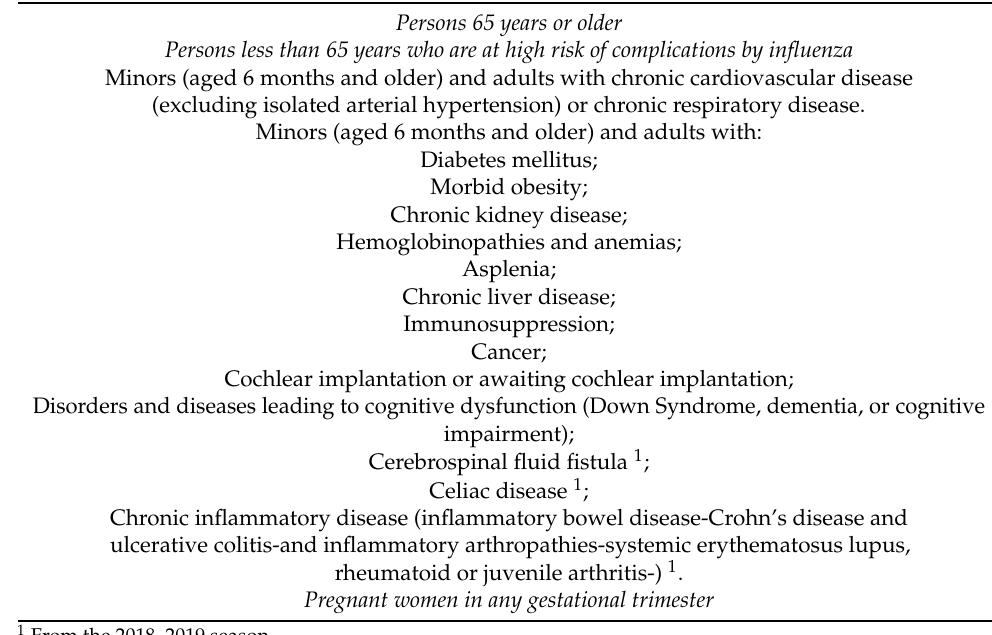
Table 2. Other target groups in which the Spanish Ministry of Health recommends influenza vaccina- tion